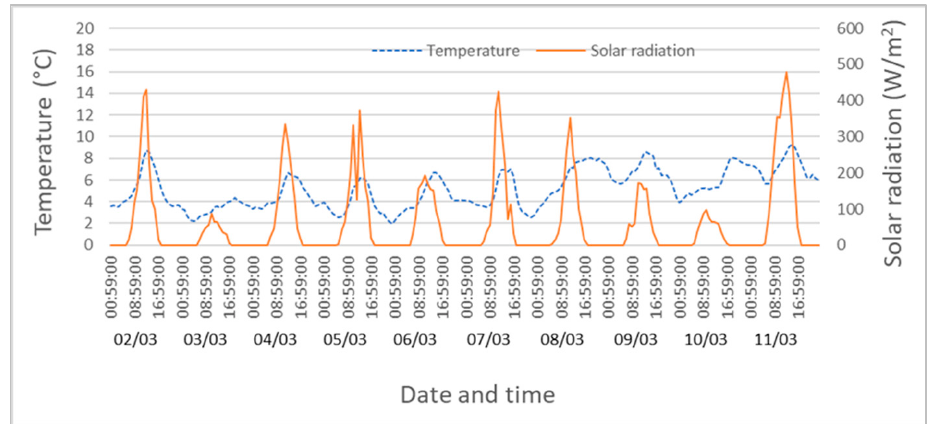
Figure 5. Ambient air temperature and solar irradiation in the location of the experiment